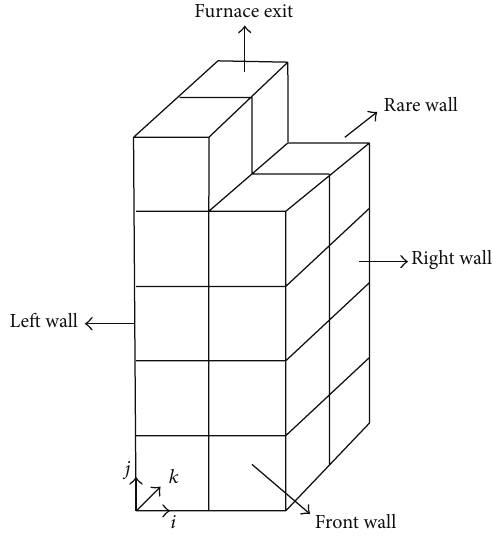
Figure 4: Total emissivity of the coupled models and benchmarks for different path lengths and soot concentrations.